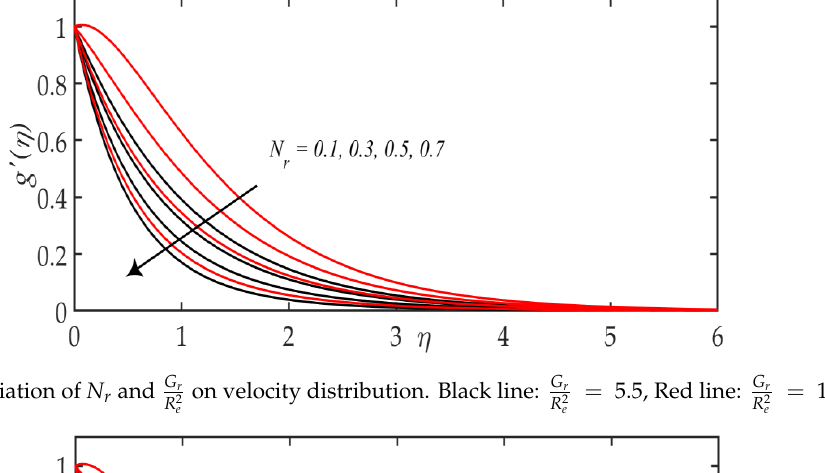
on velocity distribution. Black line: 𝐺 𝑟 𝑅 𝑒2